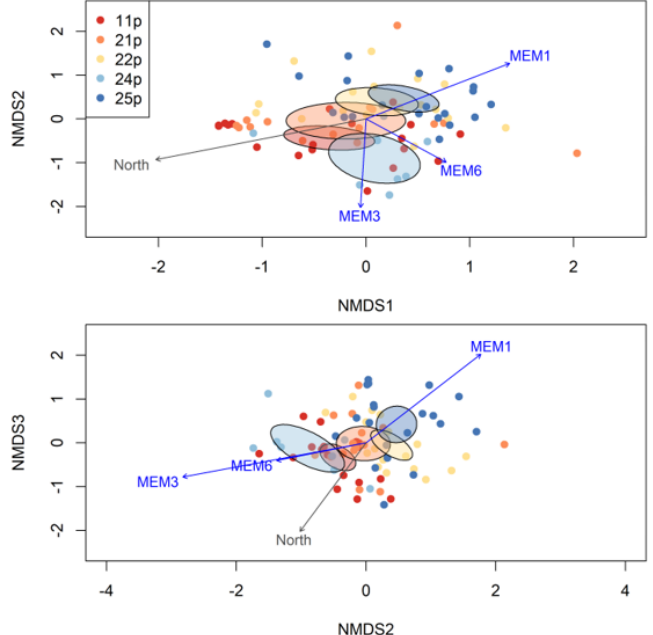
Figure 4. A 3-dimensional NMDS ordination based on Bray–Curtis dissimilarities (stress = 0.16). Arrows show statistically significant associates of the NMDS projection based on vector fitting analyses. Arrows point in the direction of most rapid increase along projection axes. Arrow length is scaled by the magnitude of R 2 statistics (Table 3). Ellipses are 95% confidence ellipses for the true bivariate centroids of maternal family OTU communities within the projection.